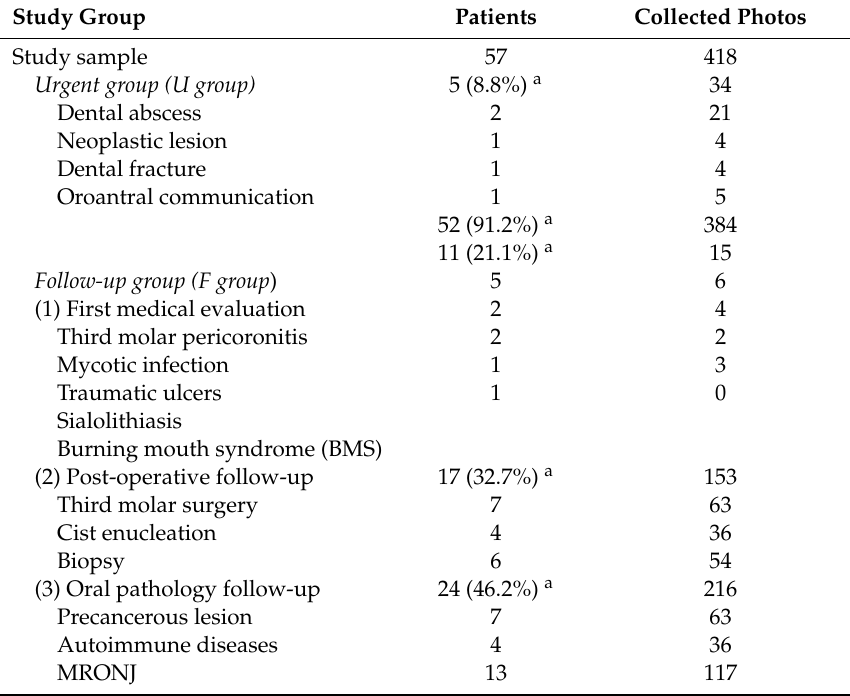
Figure 1. A female patient, 28 years old, undergoing a periodic follow-up after a surgical treatment of third molar removal. The collection of photos highlighted the ease of taking good quality photos and examining them, allowing management through telemedicine. Table 2. Patients’ distribution and photo collection for each